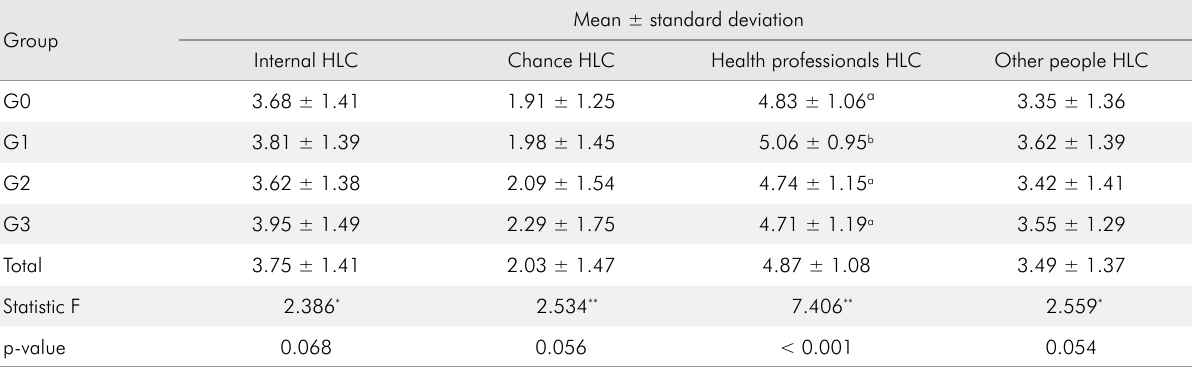
Table 7. Comparison of the weighted global score (mean ± standard deviation) of the Health Locus of Control - Form C scales (HLC-C) among groups with different pain conditions.